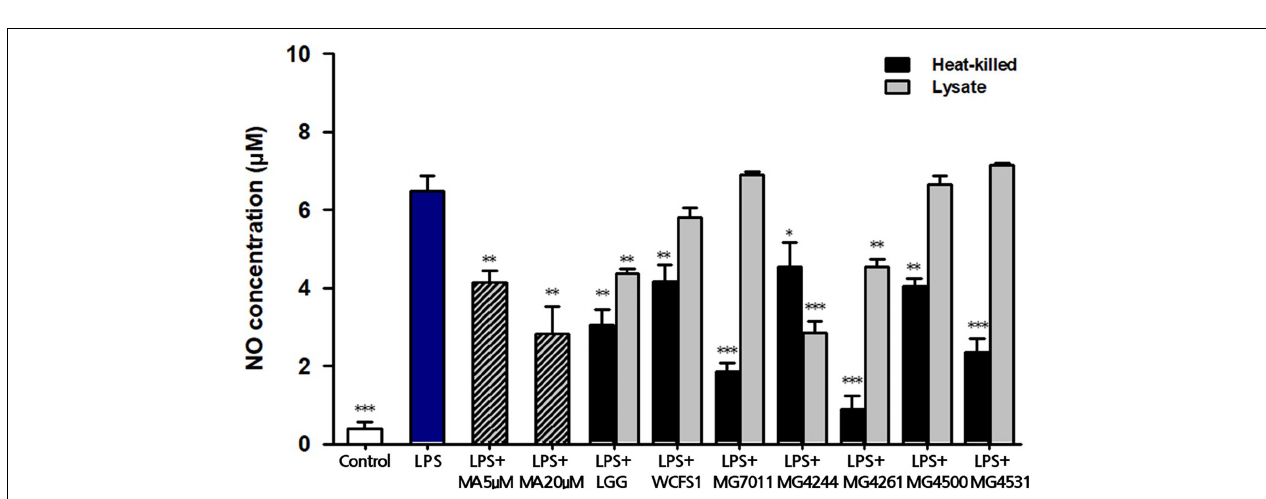
FIGURE 4 | Inhibitory activity of heat-killed and lysate forms of Limosilactobacillus fermentum cells on nitric oxide (NO) production in LPS-induced RAW264.7. MA, methyl arginine was used as positive control. Data represent the mean ± SD ( n = 3). ∗ p < 0.05, ∗∗ p < 0.01, ∗∗∗ p < 0.001 compared with